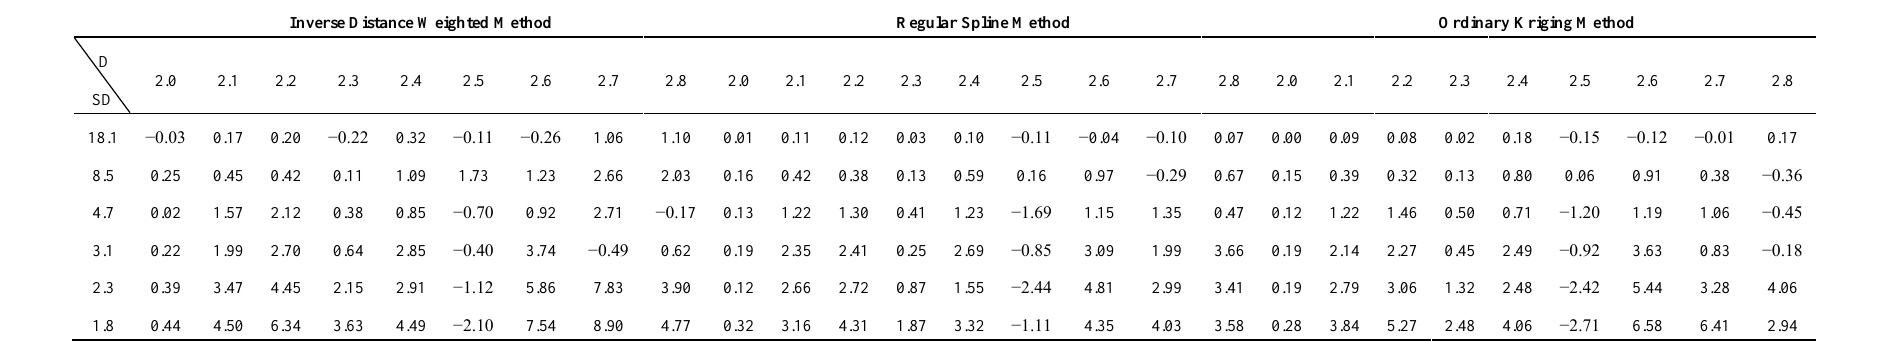
Table 6. The BIAS s under combined sampling mode (Unit: